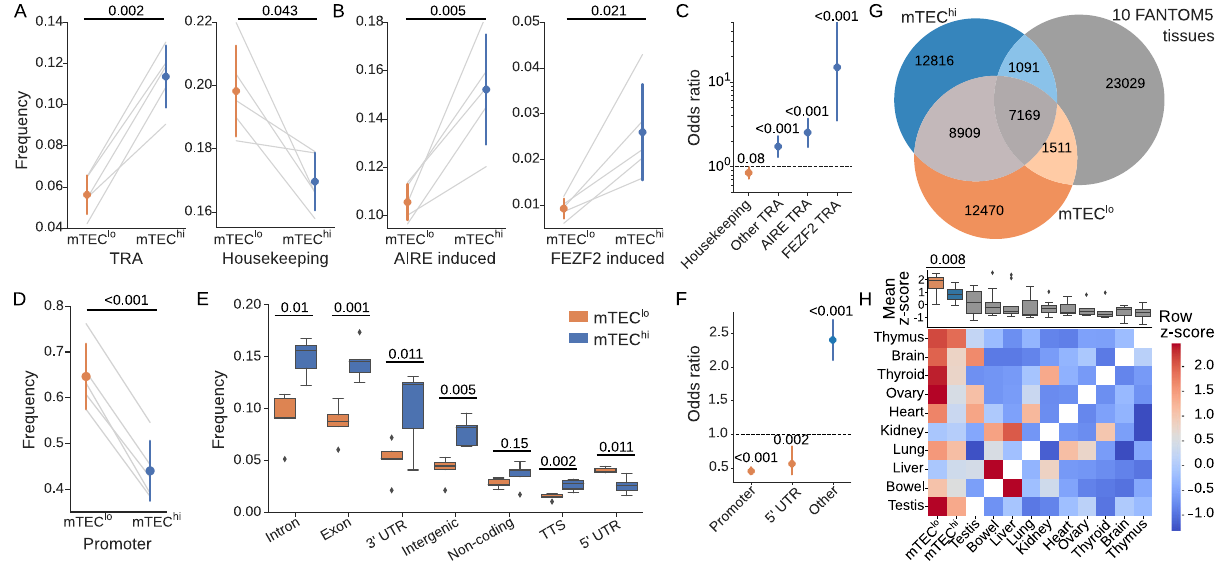
Fig. 2 The mTEC hi population has increased rates of transcript mis-initiation. Comparison of the frequency with which transcription start regions (TSRs) are associated with A tissue-restricted antigens (TRAs), housekeeping genes, B autoimmune regulator (AIRE)- and FEZF2-dependent genes between paired (gray lines) human mTEC lo (orange) and mTEC hi (blue) samples. C mTEC hi vs. mTEC lo odds ratio comparing the frequency of FEZF2- and AIRE- induced TRAs, other TRAs not associated with FEZF2 or AIRE, and housekeeping genes. D Fraction of mTEC-population-speci fi c TSRs mapping to known promoter regions. E Distribution of genomic location annotations for TSRs unique to either the mTEC hi or mTEC lo populations. Boxplots show median values with interquartile ranges and extrema (whiskers at 1.5× IQR). Outliers beyond 1.5× IQR are shown as dots. TTS transcription termination site, UTR untranslated region. F mTEC hi vs. mTEC lo odds ratio for TSRs falling into 5' UTR, known promoter regions, and all other annotated regions. G Overlap between TSRs found in at least one mTEC hi , mTEC lo , and/or normal FANTOM5 peripheral tissue sample 50 . H Leave-one-out analysis 51 comparing TSR usage across mTEC hi , mTEC lo , and 10 pooled peripheral tissue samples from the FANTOM5 consortium. In brief, one sample type was excluded and the set of TSRs unique to one tissue type among the remaining samples was calculated. The fraction of TSRs expressed in the excluded sample was then reported for each set of otherwise tissue-speci fi c TSRs as a row z -score. The top barplot shows the column mean z -score across all tissue types. Error bars show either standard deviation ( A , B , D ) or 95% con fi dence intervals ( C , F ). Odds ratio values ( C , F ) greater than 1 represent increased use in mTEC hi TSRs; bars color-coded by population with increased odds. Values above horizontal bars indicate p values derived by two-sided paired t -test ( A , B , D , E , H ) or two- sided Fisher's exact test ( C , F ); all panels: n = 5 paired mTEC samples. Source data for all panels are provided in the Source Data fi